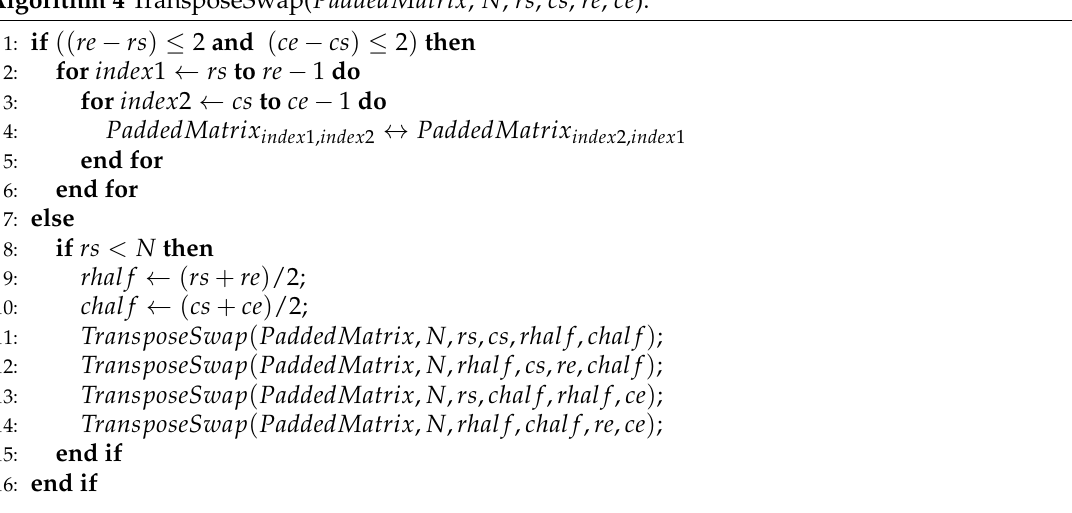
Algorithm 4 TransposeSwap( PaddedMatrix , N , rs , cs , re , ce